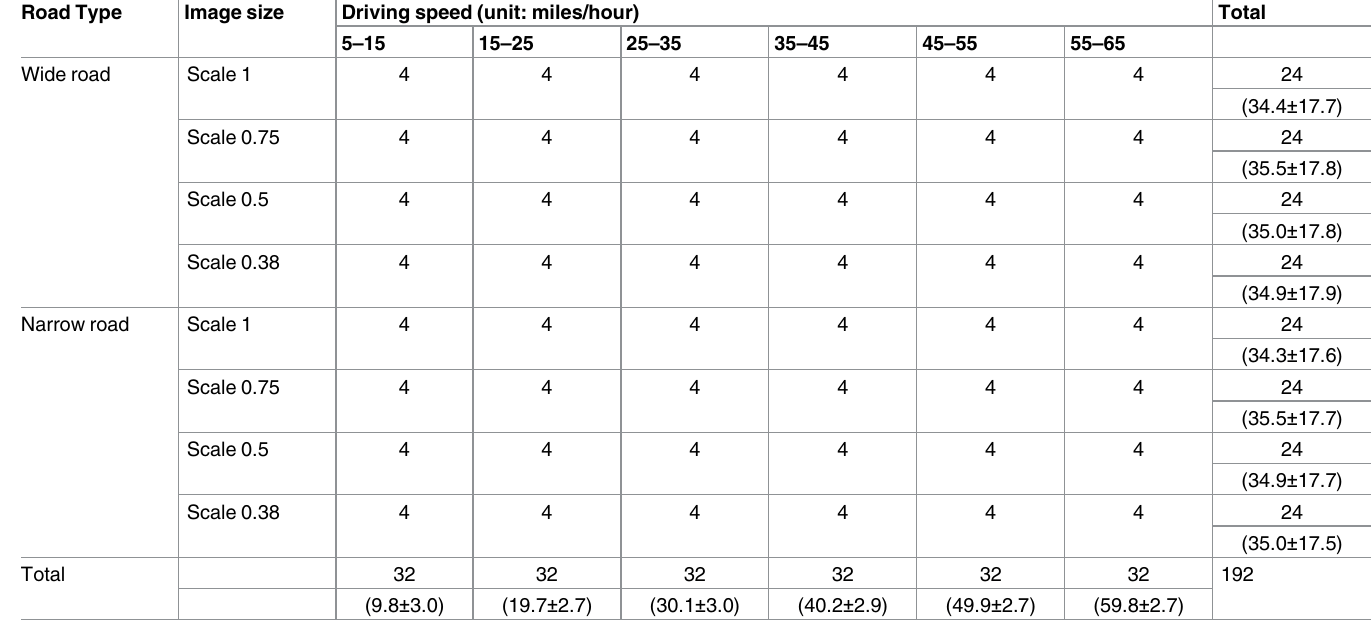
Table 1. The distribution of the 192 driving video clips. Numbers in parenthesesare speedmean and standard deviationof the column or row. Road